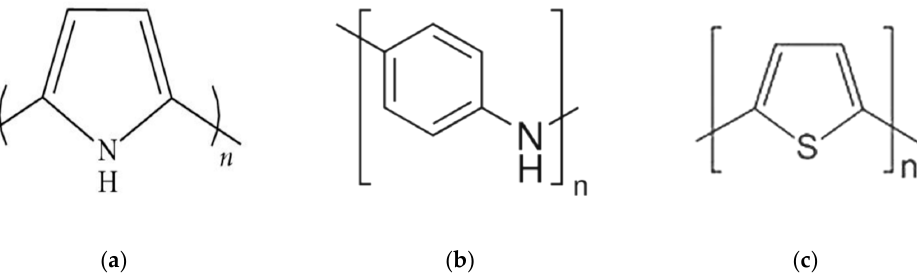
Figure 1. Chemical structure of the most common conductive polymers: ( a ) Polypyrrole; ( b ) Polyaniline; ( c ) Polythiophene.